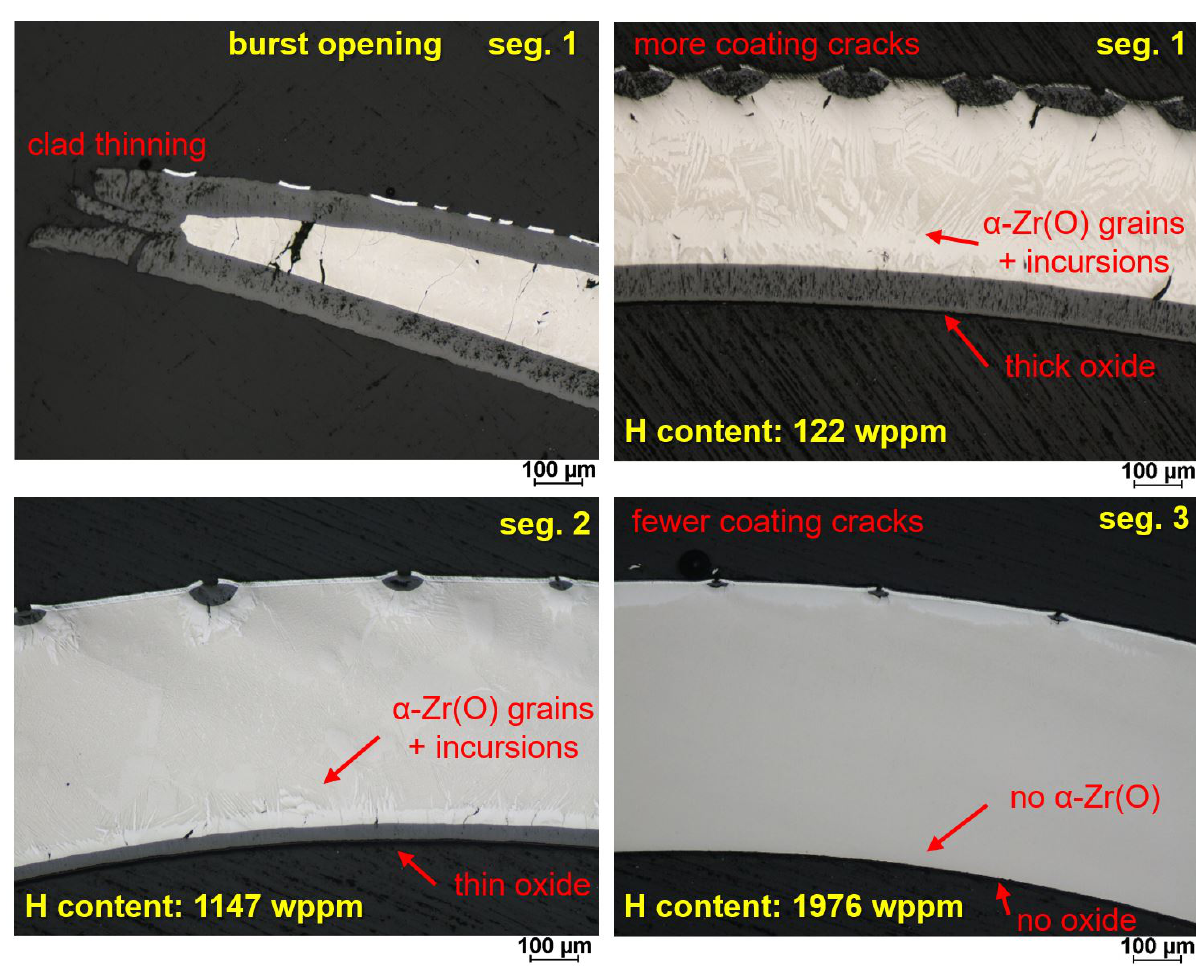
Figure 11. Results of secondary hydriding